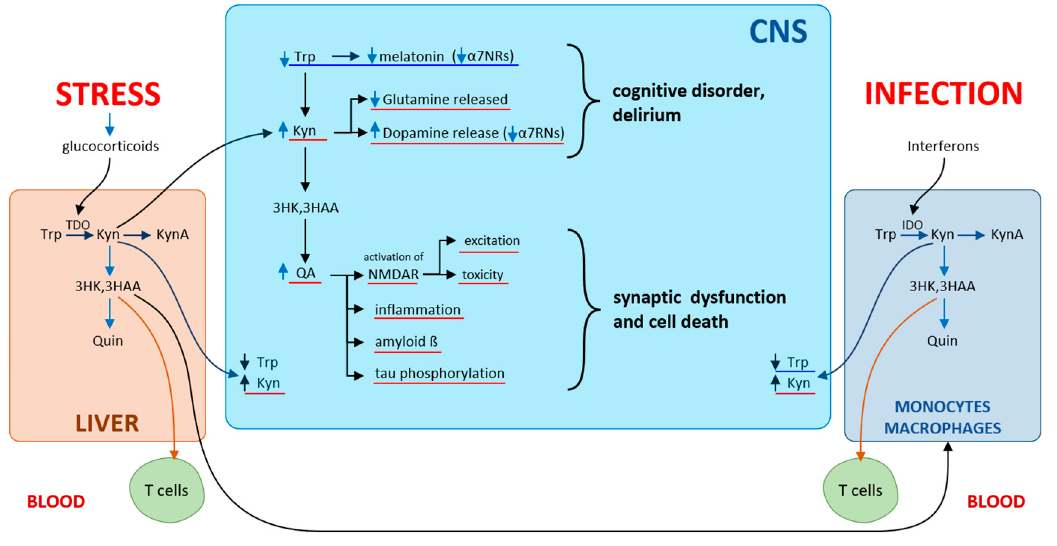
Figure 7 . Kynurenines and cognitive disorders according to [44]. The influence of stress on kynurenine pathway via glucocorticoid secretion induces TDO in the liver, while infections via interferons induce IDO in several subsets of leucocytes. Depletion of Trp and increasing cerebral levels of kynurenines produce behavioral and cognitive changes.